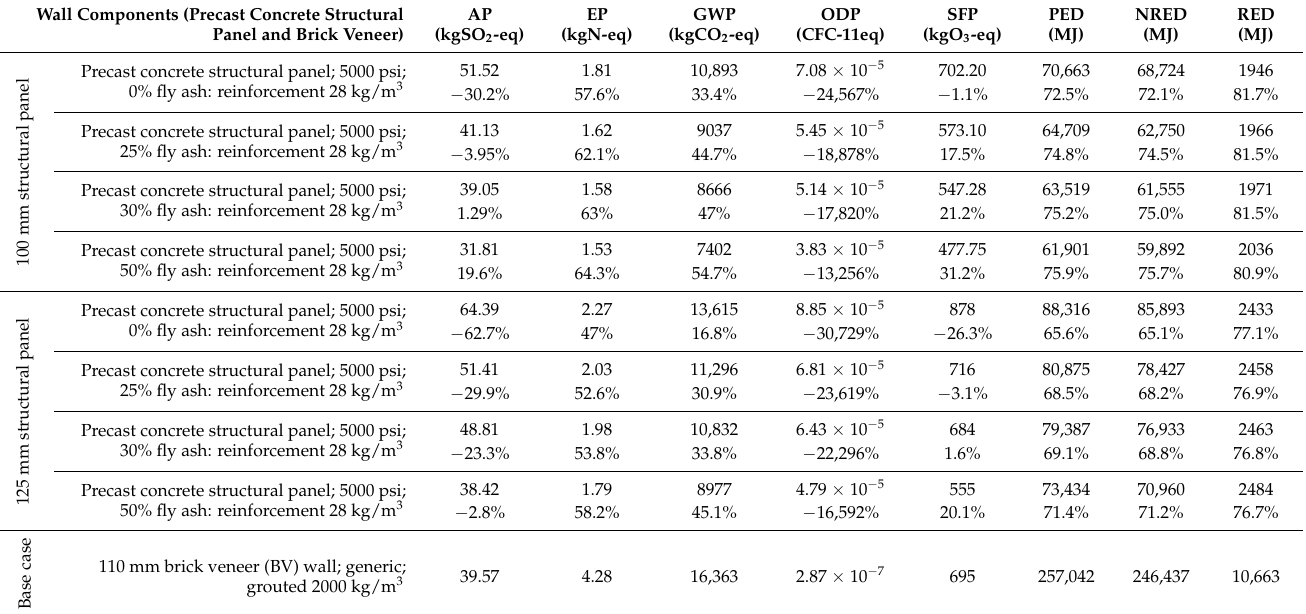
Table 6. Embodied energy of conventional and prefabricated wall